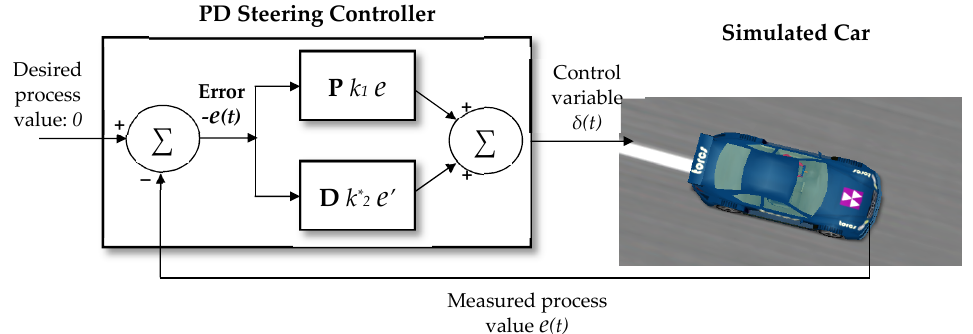
Figure 5. Servo-control model of steering as a PD steering controller. The steering angle function (SAF), defining the steering angle δ is implemented as a sum of the proportional-(P) and derivative (D) terms of the error —the deviation e from the center of the lane.